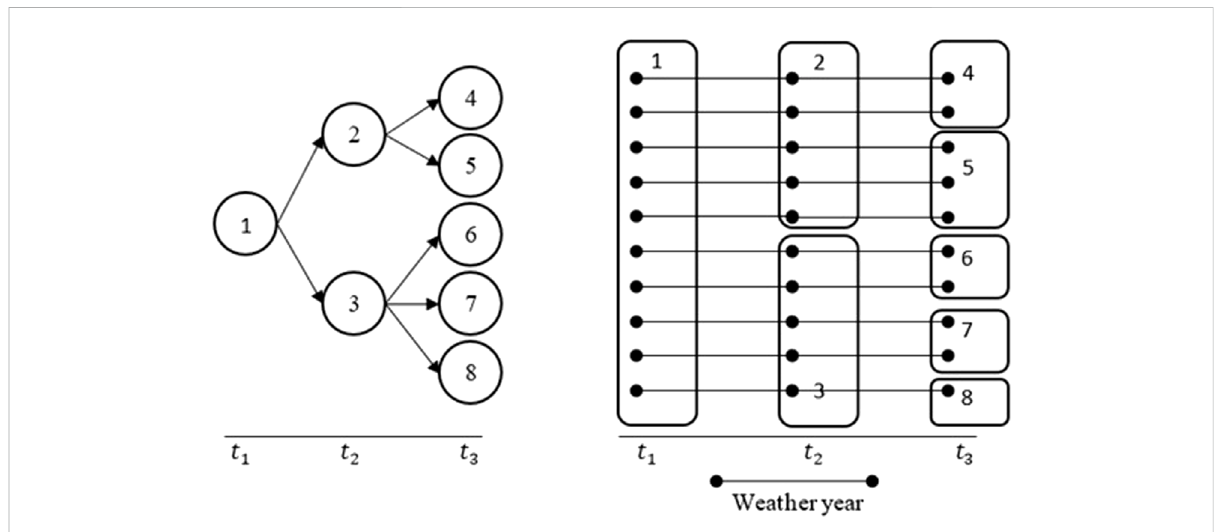
FIGURE 2 Decisions Tree and Threshold Partitioning